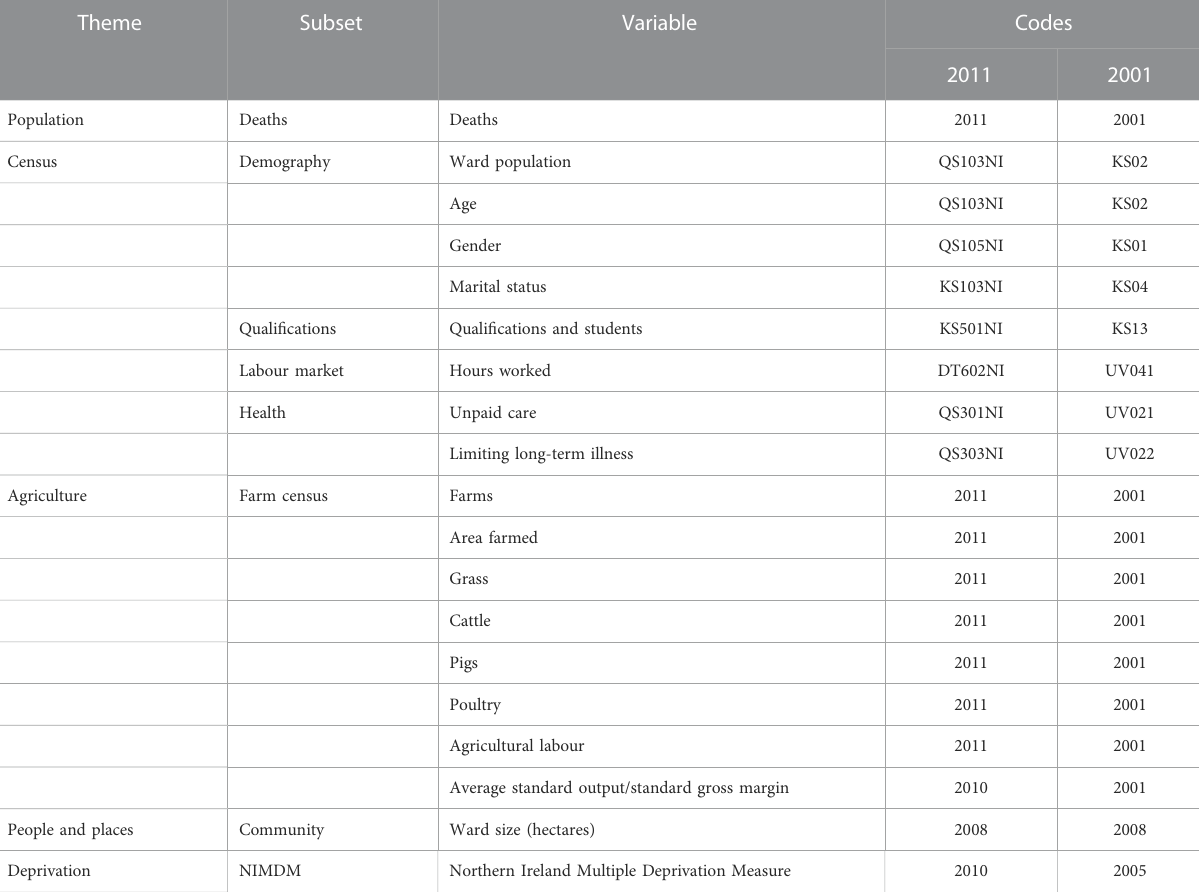
TABLE 1 Themes, subsets, names, and codes of raw variables extracted from the NINIS website to create 2001 and 2011 mortality